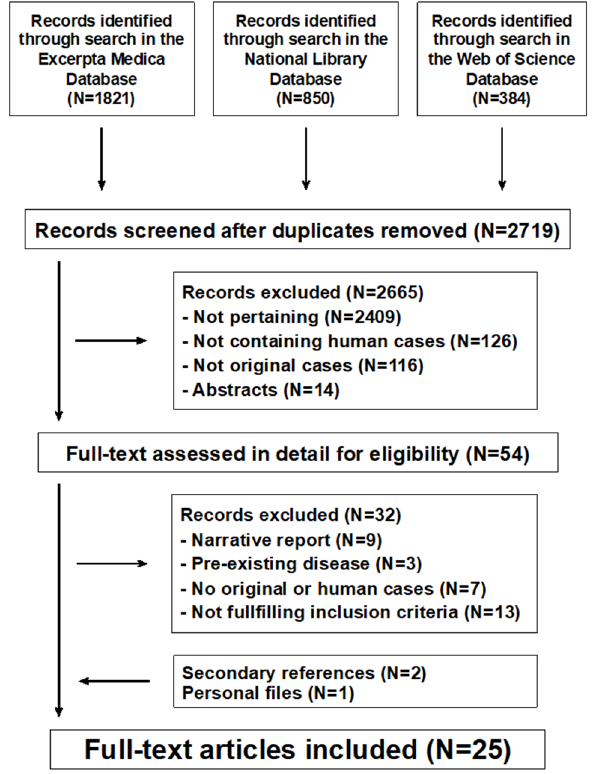
Figure 1. Magnesium metabolism in chronic alcohol-use disorder. Flowchart of the literature search process.